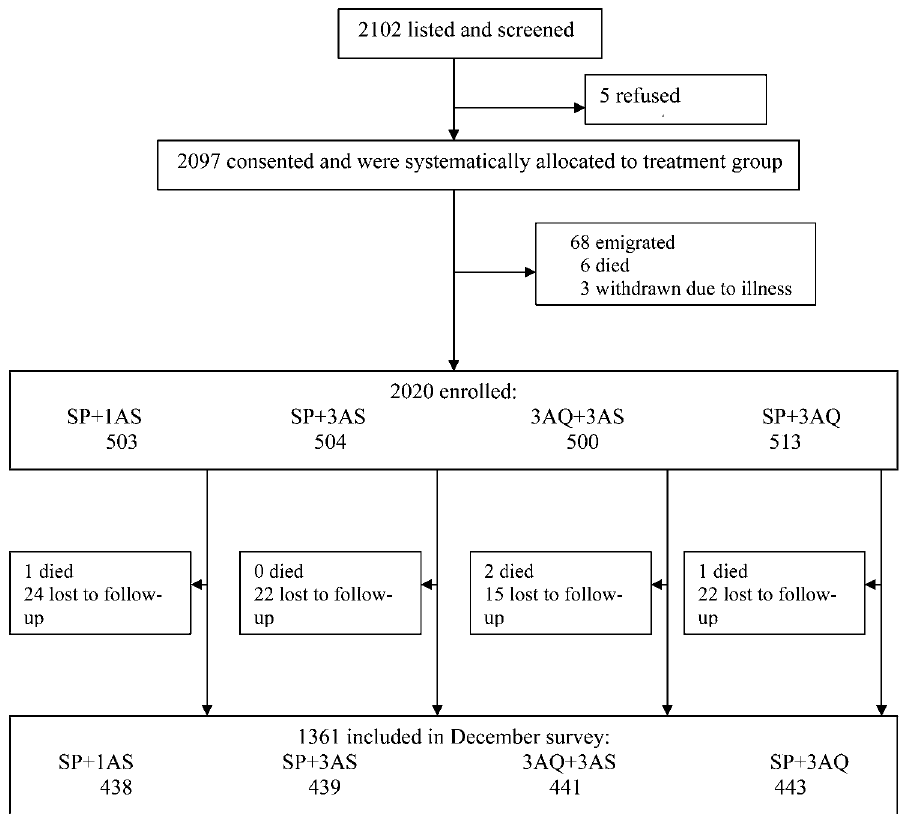
Figure 1. Trial profile.